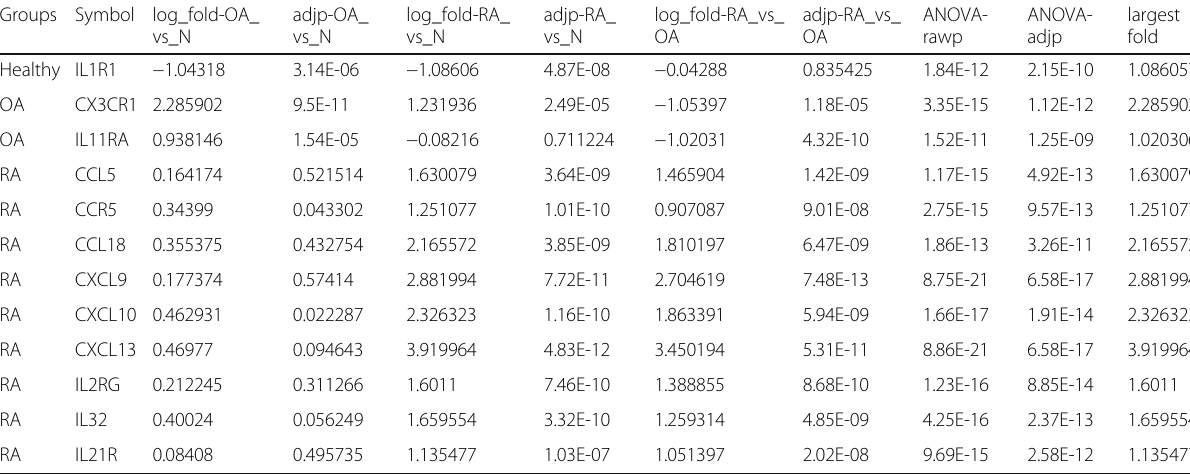
Table 3 Top chemokine and interleukins related genes in the DEGs specific to RA compared to healthy and